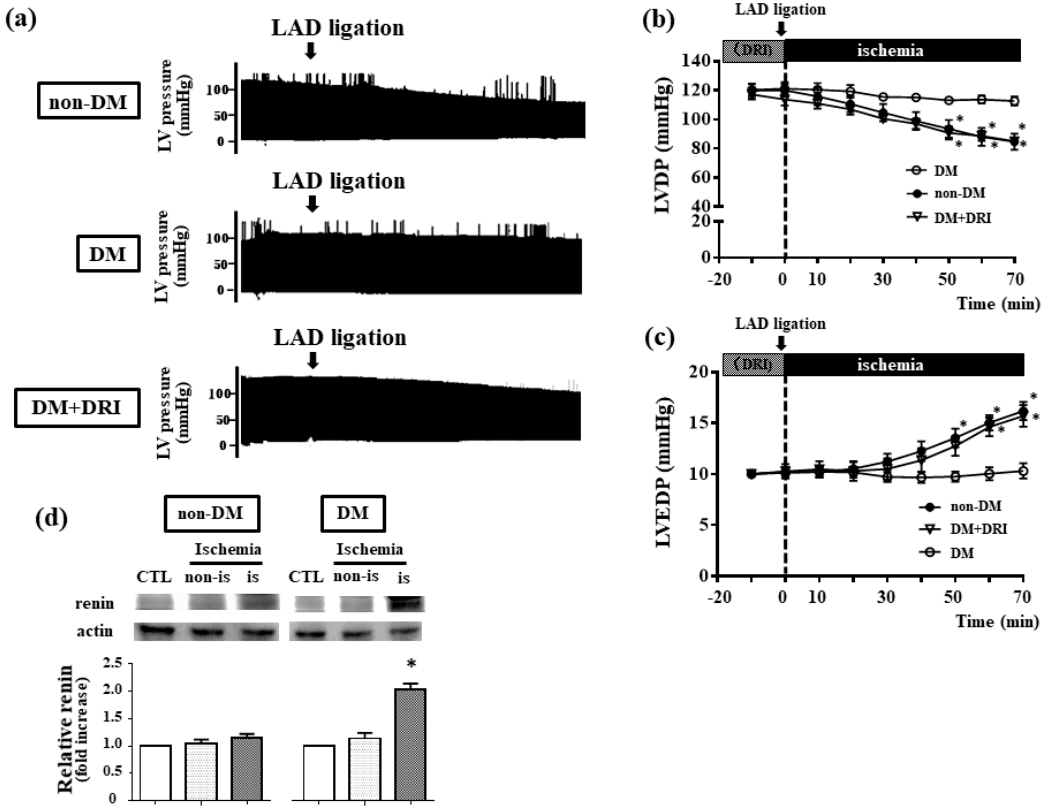
Figure 1. DM hearts exhibit ischemic resistance through ERK1/2 activation. ( a ) Representative recordings of left ventricular (LV) pressure in non-DM and DM hearts. Langendorff-perfused hearts were subjected to 70 min ischemia by left anterior descending artery (LAD) ligation. A direct renin inhibitor (DRI; aliskiren) was added 20 min before coronary ligation; ( b , c ) Time courses of changes in left ventricular developed pressure (b: LVDP) and left ventricular end-diastolic pressure (c: LVEDP) during ischemia in non-DM ( ● , n = 6), DM ( ○ , n = 6), and DM + DRI ( ∇ , n = 4). Values are the means ± standard error of the mean SEM. * p < 0.05 vs. non-DM hearts by two-way analysis of variance (ANOVA); ( d ) Western blot analysis of renin in both non-DM and DM hearts. The samples were obtained from the non-ischemic hearts (CTL), non-ischemic area (non-is), and ischemic area (is) from ischemic hearts. Data are presented as fold-increase of renin/actin ratio from CTL, and values are the means ± SEM from 3 isolated experiments . * p < 0.05 vs non-ischemic control (CTL) of DM heats by two-way ANOVA.